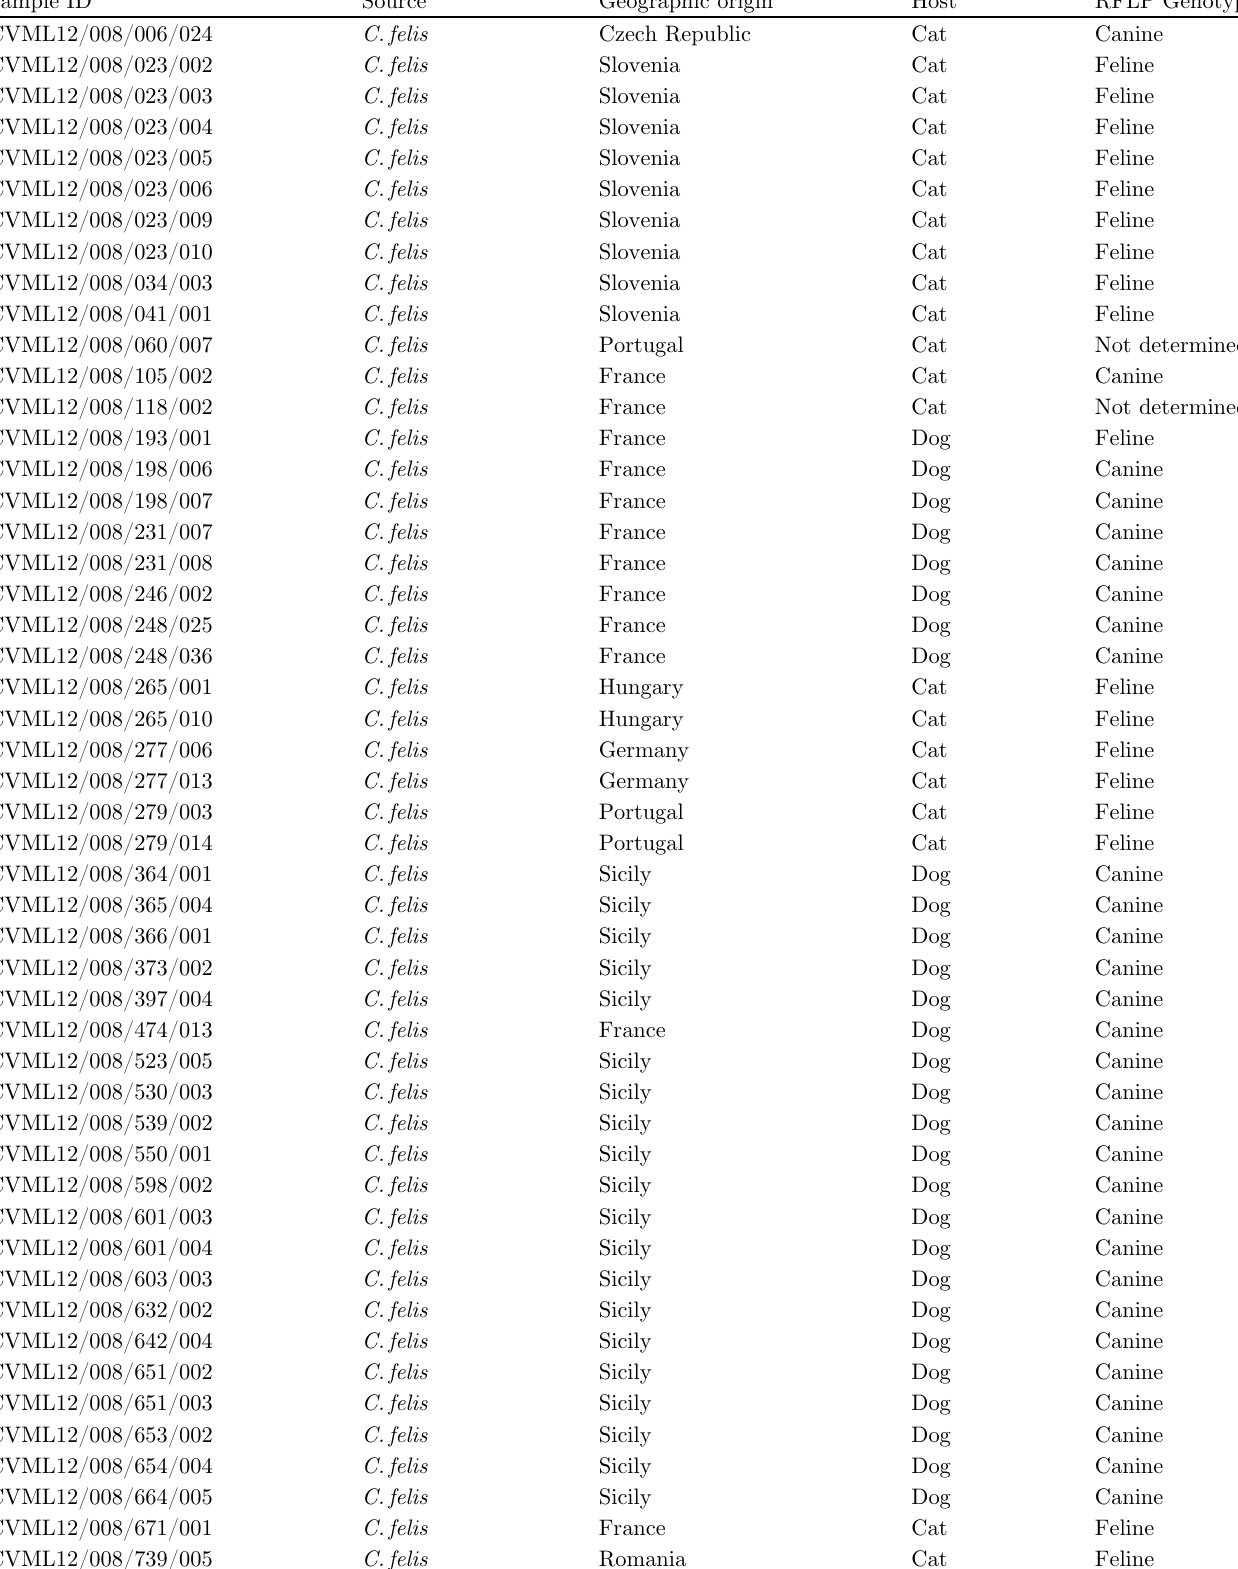
Table 1. Details on two distinct 28SrDNA sequence variants ( “ canine ” and “ feline ” ) de fi ned from fl eas infected by Dipylidium caninum , obtained from PCR products collected by Beugnet et al. [3] from Europe and South